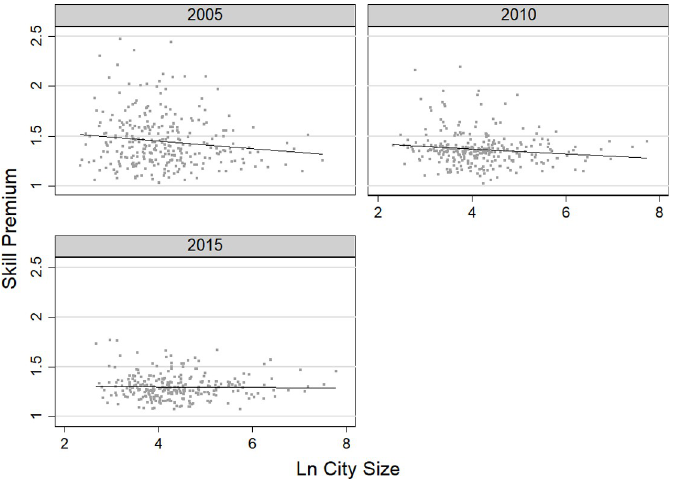
(4) Rent elasticity. Fig 5 shows the relationship between rent and city size. The elasticity